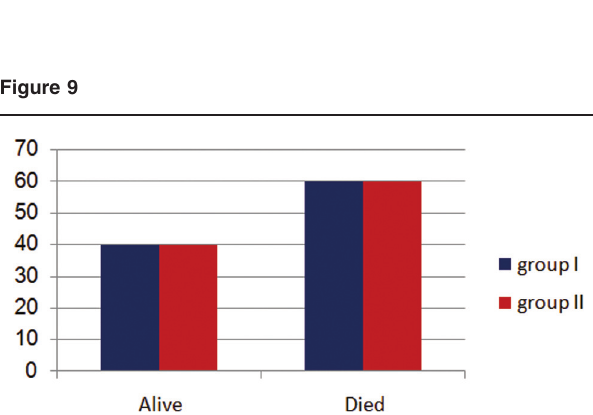
Comparison between groups regarding progression to ventilator- associated